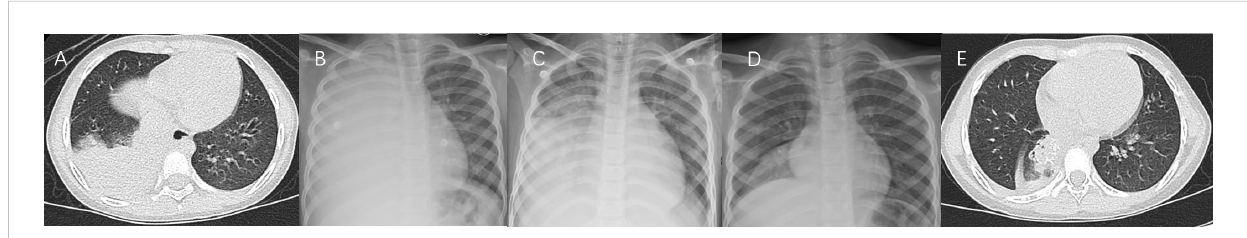
FIGURE 5 Case 5. Chest imaging showed right high-density lesions ( A , day 4; B , day 8; C , day 10) and right pleural effusion (B, C) , and right localized atelectasis ( D , day 70; E , 19 months after illness